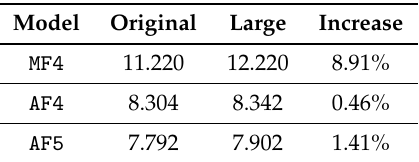
Figure 7. In order to demonstrate that the proposed autoencoder architecture is size-independent, 80 × 80 images containing multiple digits from the MNIST data set [7] were generated. The extended images contain up to four objects. Table 7. The autoencoders trained in Section 4.1 were used with larger images, as shown in Figure 7. An average per-object error was calculated and compared to the original results, related to the objects with a single centered object. The information on the relative error increase is included in the table as